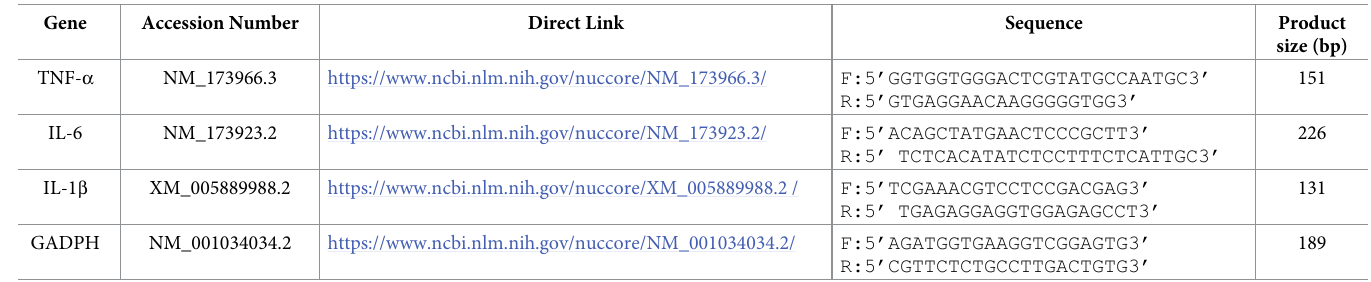
Table 1. Quantitative real-time PCR primer